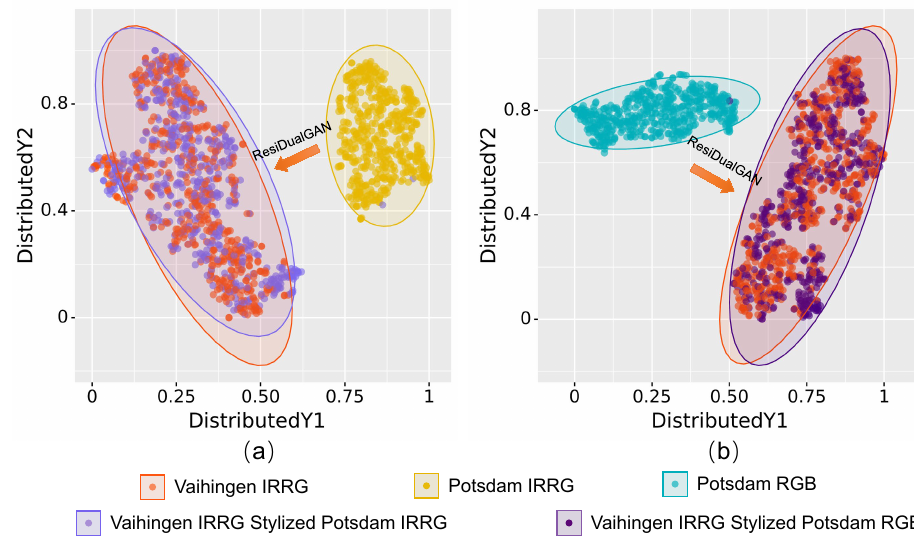
Figure 9. The visualization of distribution matching in latent space, where we map features to 2D space with t-SNE [46]: ( a ) Potsdam IRRG → Vaihingen IRRG; ( b ) Potsdam RGB → Vaihingen IRRG.